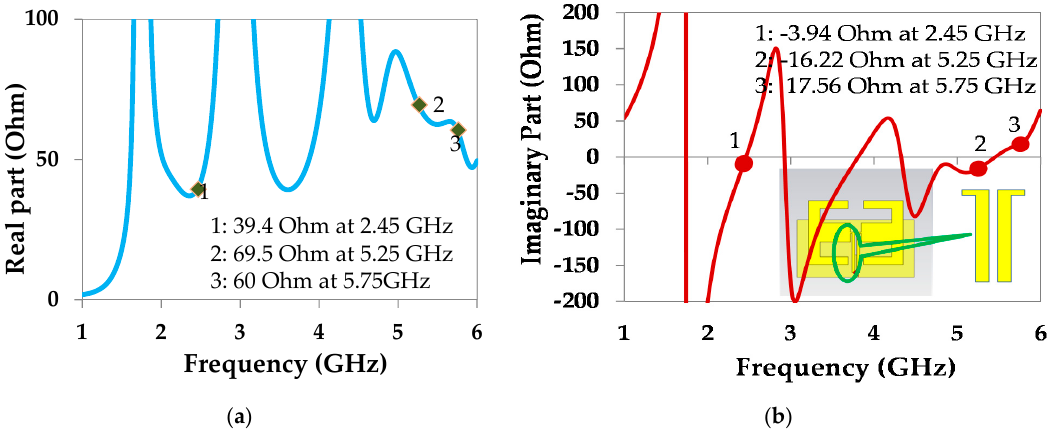
Figure 3. Antenna input impedance: ( a ) Real part; ( b ) Imaginary part.